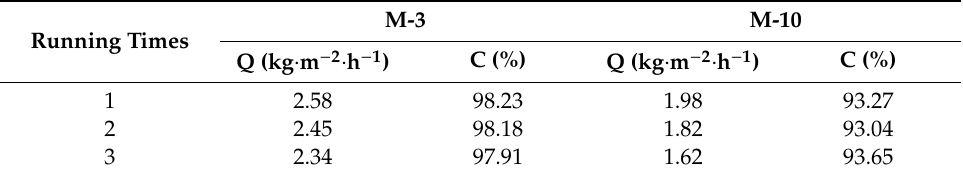
Table 5. Repeatable catalytic performance of TS-1 zeolite membranes (M-3 and